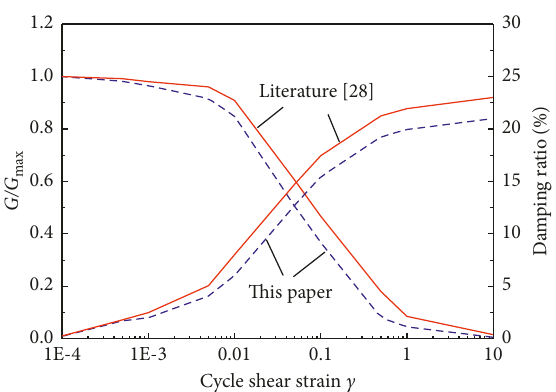
Figure 4: Comparison of the ( G )/( G )